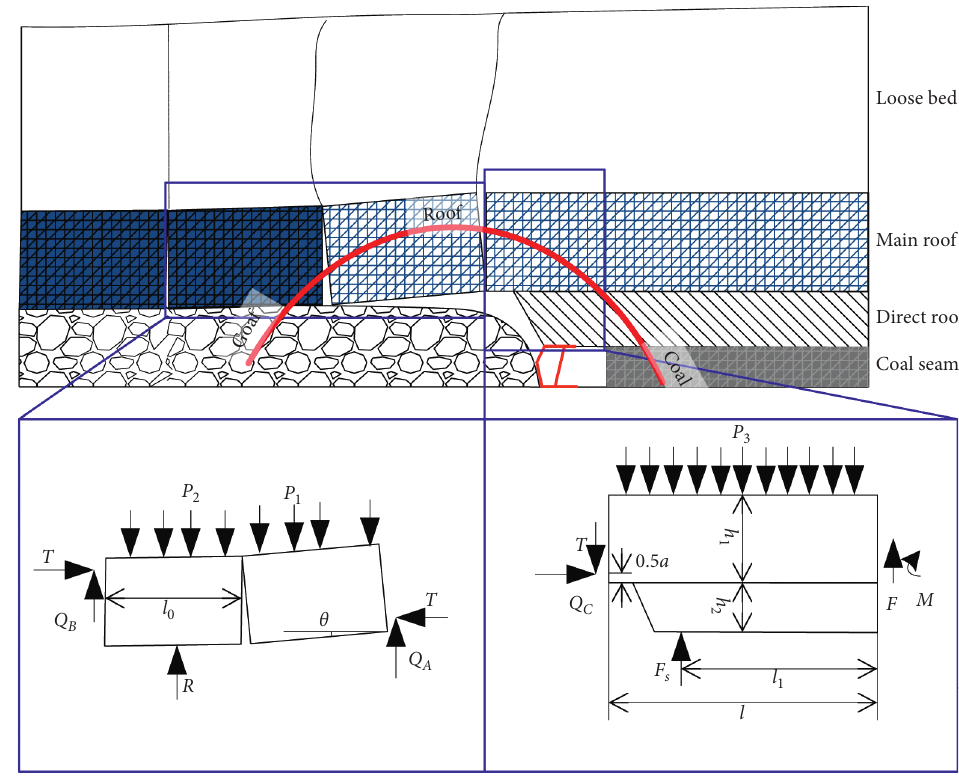
Figure 4: Structure characteristics above removal